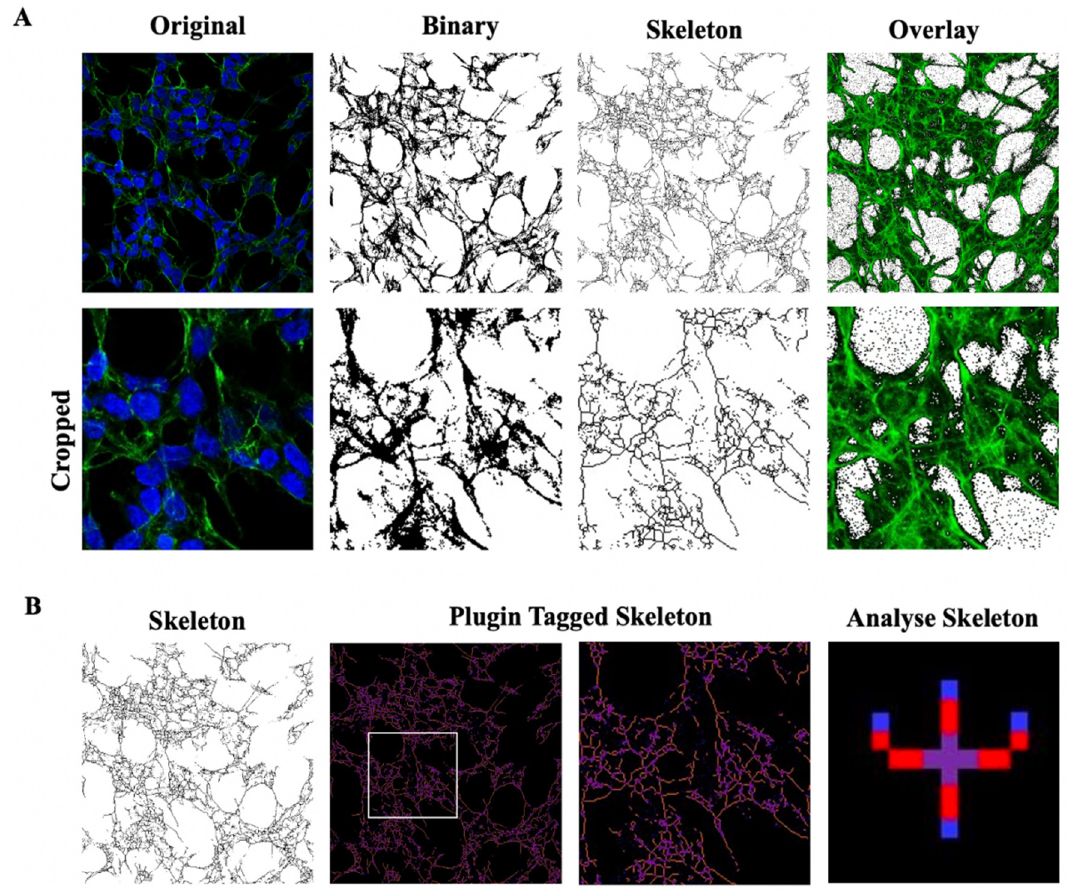
Figure 12. Skeleton Analysis application to quantify cells morphology. ( A ) Representative photomicrograph (40 × magnification) and the series of ImageJ plugin protocols of SH-SY5Y cells, which were applied to each photomicrograph for skeleton analysis. Original photomicrograph was modified enhancing the background, removing noise and using with FFT filter prior to be converted to binary images. Binary image was skeletonized. The overlay of skeletonized and original images is reported; cropped photomicrographs show the image details. Scale bar: 20 µ m. ( B ) The workflow used to analyze Skeleton plugin: skeletonized process in orange, endpoint in blue, and junction in